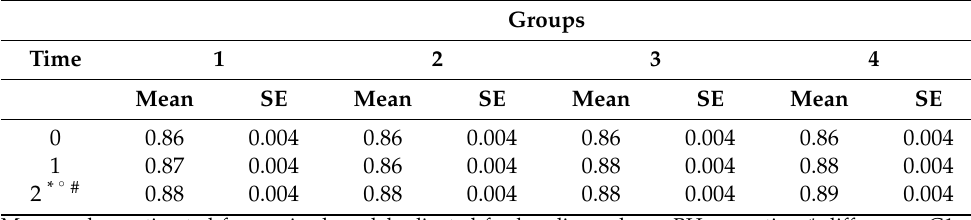
Table 4. Estimated mean from mixed model corrected by baseline